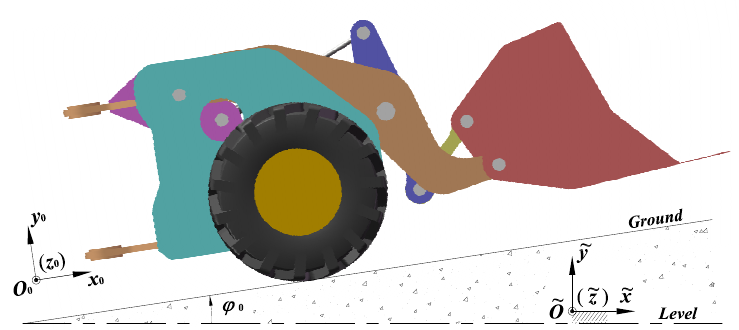
Figure 3. Pitch motion of reference vehicle.